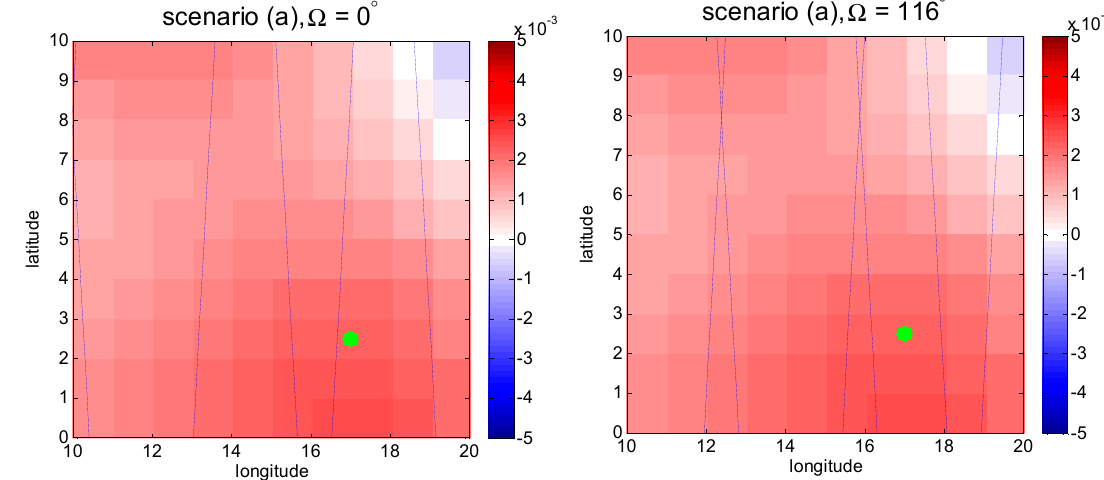
Figure 19. Groundtrack of the scenario (a) over West-Africa for left : Ω = 0°, and right : Ω = 116 ° (where sub-cycle happens).